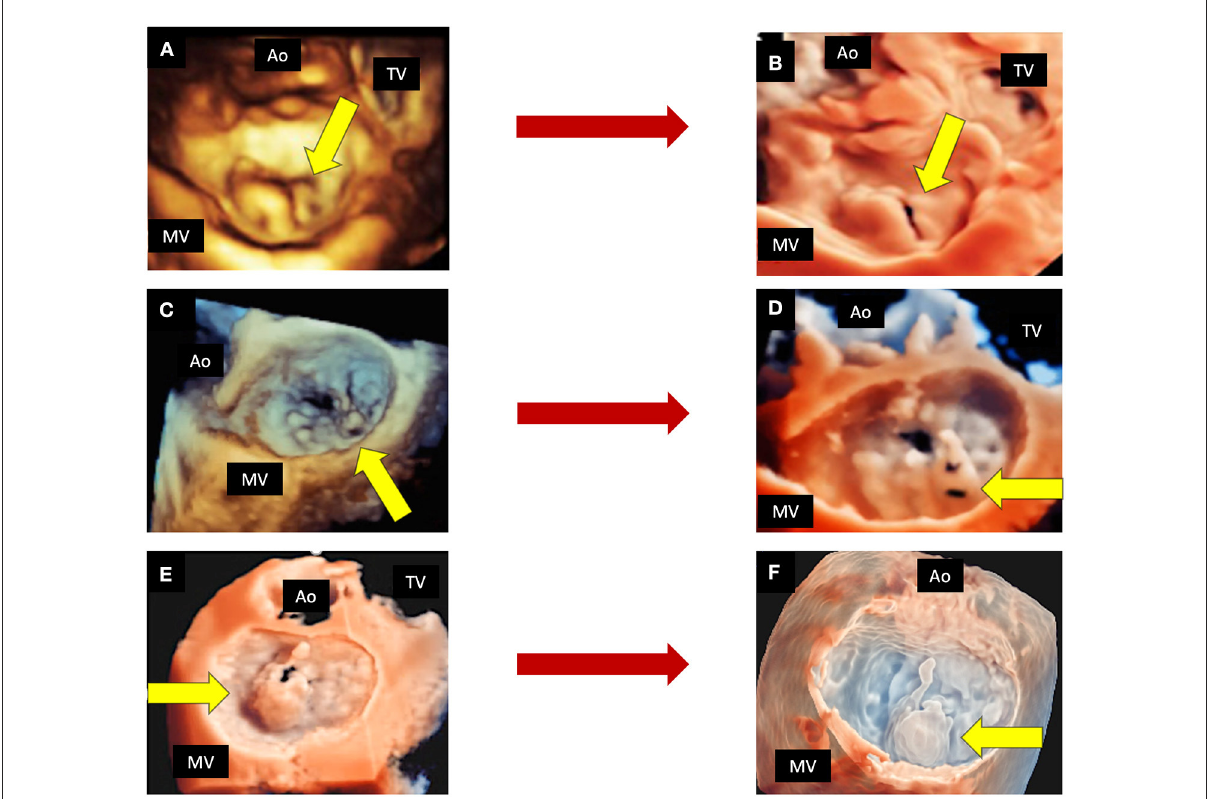
FIGURE4 The role of new 3D tools in echocardiography. Shown are three examples of MVP, in which new tools may improve the quality of imaging. Top panels show a P2 prolapse by standard 3D TTE (A) and by TI rendering (B) . Mid panels show a complex P2 prolapse by standard 3D TEE (C) and by TI rendering, which clearly shows the fragile texture of the leaflet (D) . Bottom panels show a P2 flail by 3D TEE applying the TI tool (E) and the transparency effect (F) . 3D, three-dimensional; Ao, aorta; MV, mitral valve; TEE, transesophageal echocardiography; TI, transillumination. TTE, transthoracic echocardiography; TV, tricuspid